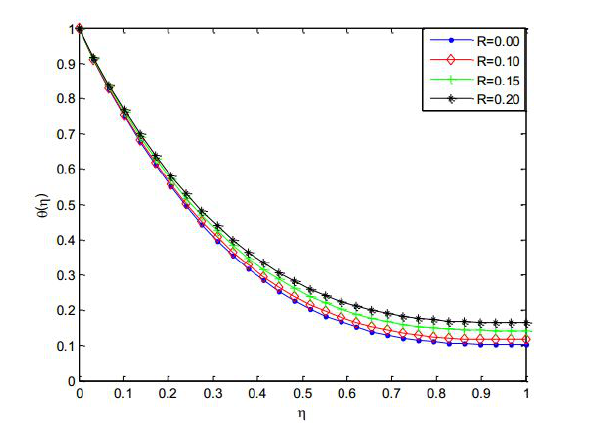
Figure 3. Effects of radiation parameter on temperature profile of the Cu-Kerosene Casson-Carreau